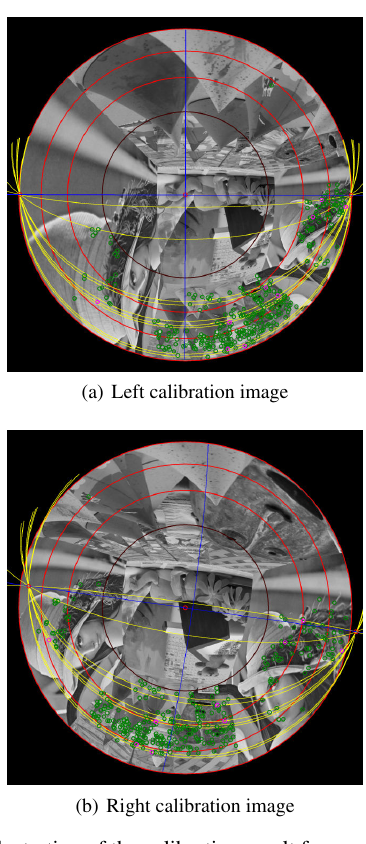
Figure 5: Illustration of the calibration result for a couple of syn- thetic fisheye images. Red large circle represents the limit field of view of the lens. The red point in the middle is its center. Op- posite red points in left and right sides are the epipoles’ projec- tions on the image. Blue line passing through the image’s center and both epipoles is the epipolar axis. Green and magenta points are fitting the model (inliers). 9 magenta points are those used to reach the better estimation with RANSAC . Yellow curves are epipolar curves. Perpendicular blue arc represents the scan-arc.